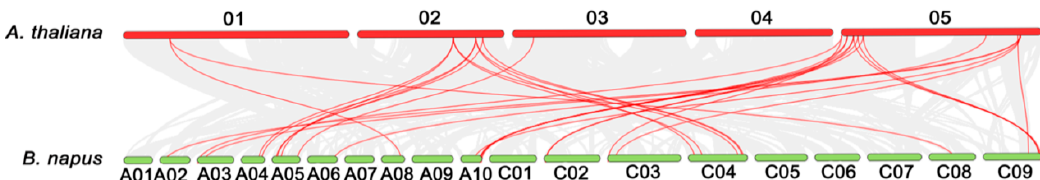
Figure 1. Interchromosomal relationships of BnLACs and gray lines indicate duplicated LAC gene pairs. The chromosome number and gene ID are indicated with red and black, respectively. The figure was generated by MCScanX with the default parameters [30].